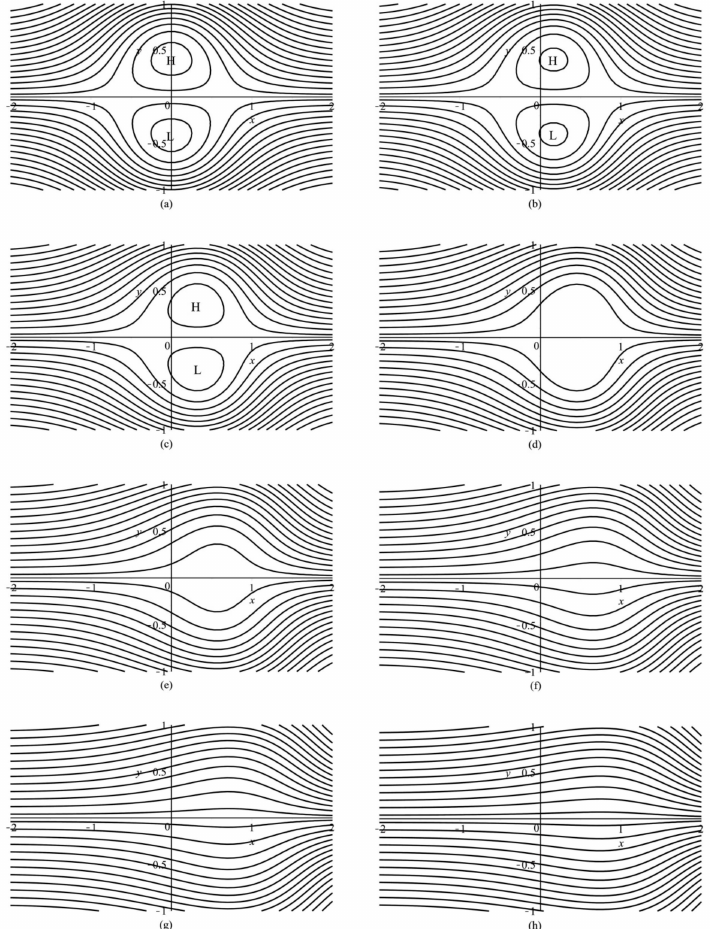
Figure 5. Blocked flow field for a dipole when ∆ T = − 9 ◦ C on the ( a ) 1st, ( b ) 5th, ( c ) 9th, ( d ) 13th, ( e ) 17th, ( f ) 21st, ( g ) 25th, and ( h ) 29th day (unit: 1500 km). In January 2008, for example, the Arctic temperature at a 2-m height over a wide area showed positive anomalies, particularly over the Barents–Kara Sea. This caused the westerlies in mid- to high latitudes to weaken [36,37] and formed an anomalous dipole consisting of a Ural blocking high and a low-pressure center over Eurasia, causing the northern branch of the circulation in the Urals to develop strongly toward the Arctic. The northern branch of the circulation then turned south from the Arctic, guiding the cold air of the Arctic in a southeasterly direction to invade East Asia (Figure 6), causing the extremely cold event recorded over eastern China in January